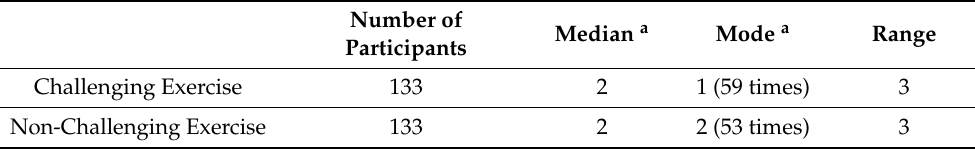
Table 1. Perceived challenge on cognitive exercise self-efficacy scores data summary.